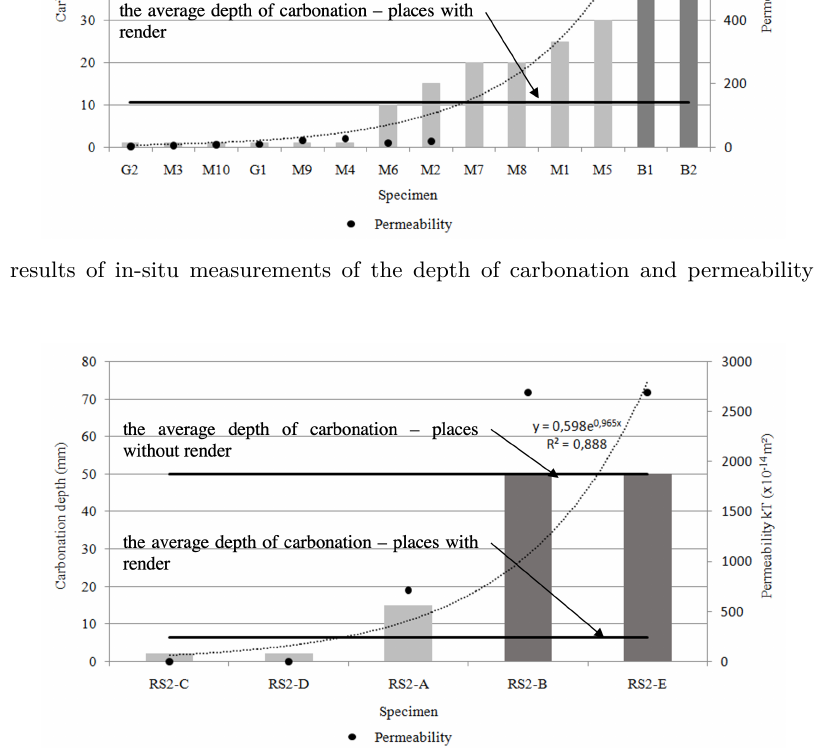
Figure 2. The results of in-situ measurements of the depth of carbonation and permeability at the Bridge in Sládkovi č ovo.